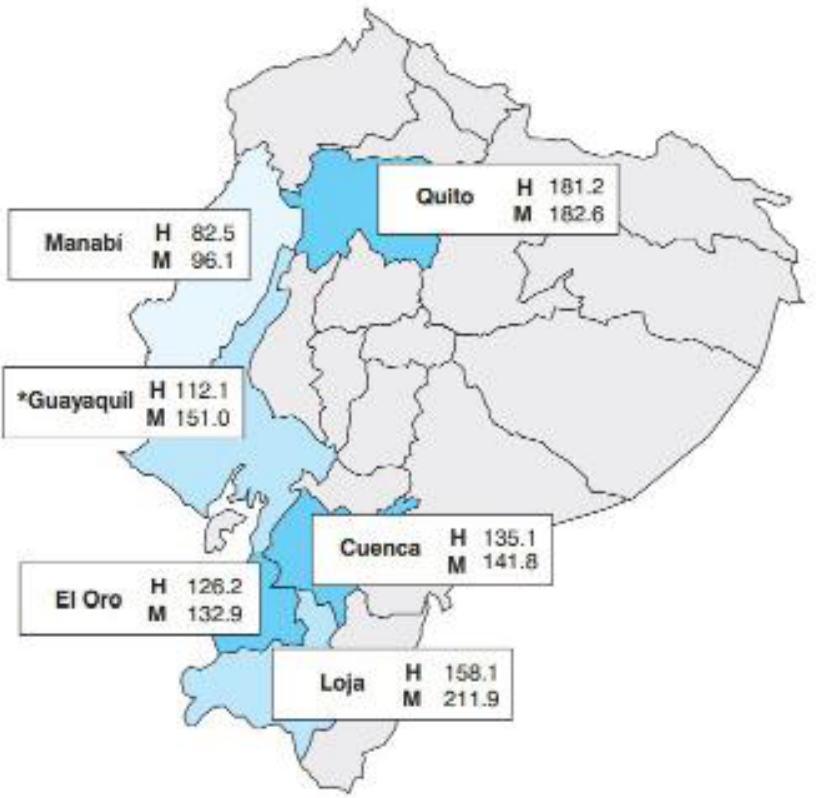
Figure 1. Standardized incidence rates in cancer registry in Ecuador. Taken from Epidemiology of Cancer in Quito 2006–2010 (2014). Capital letters correspond to H (Male) and M (Female) respectively. *: in Guayaquil, only the crude death rate is available.